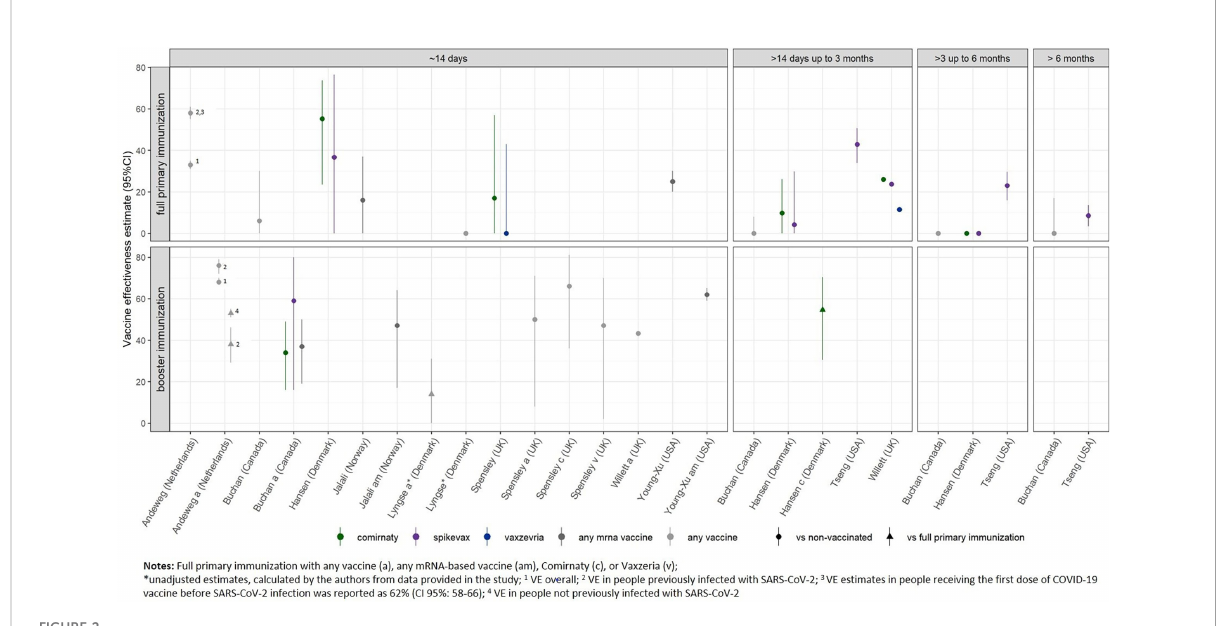
FIGURE 2 Vaccine effectiveness estimates against SARS-CoV-2 infection (any type) of the Omicron variant after full primary immunization and booster dose, as reported in the study for the de fi ned time strata after immunization. For booster immunization the COVID-19 vaccine used for primary immunization is